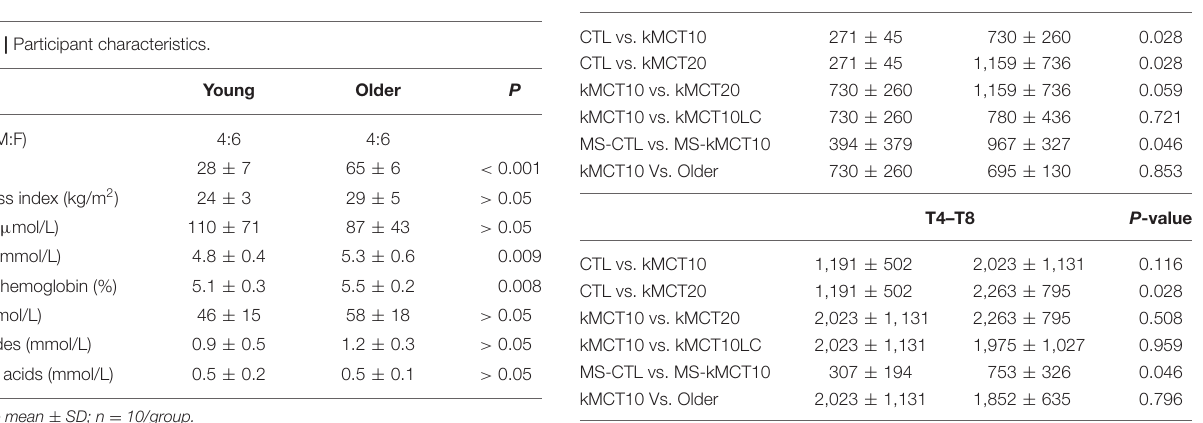
Frontiers in Nutrition |